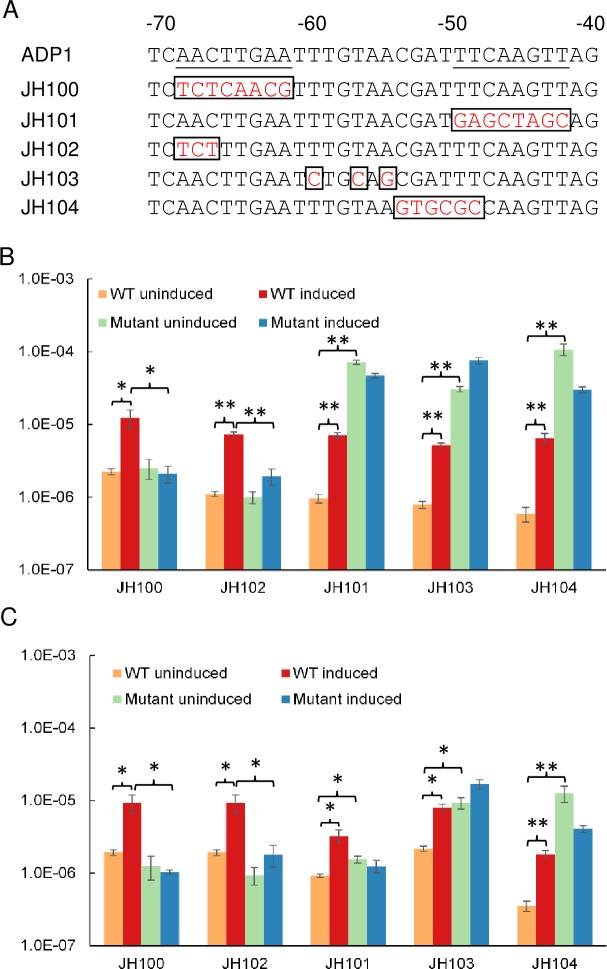
Mutation of potential operator site in umuDAb-ddrR promoter dysregulates UmuDAb-regulated gene expression.(A) Underlined nucleotides are those previously identified as possible regulatory protein binding sites (an SOS box) in ADP1, due to their palindromic nature [11]. The numbering system represents the number of nucleotides upstream of the umuDAb coding region. Nucleotides -66 through -45 (similar but non-identical in A. baumannii) were identified as required for UmuDAb binding to A. baumannii DNA fragments in vitro [10]. Mutations in ADP1 mutant strains JH100-104 are represented in red boxes. RT-qPCR experiments measured ddrR (B) and umuDAb (C) expression in uninduced or induced (2 μg/mL MMC) wild type ADP1 vs mutant cells. Each gene was assayed in one RT-qPCR experiment (plate), with error bars indicating standard error of the mean from technical triplicates of biological triplicates. Statistical significance in a Student’s t-test is indicated by the symbol * for p values < 0.05, and by the symbol ** for p values < 0.01.